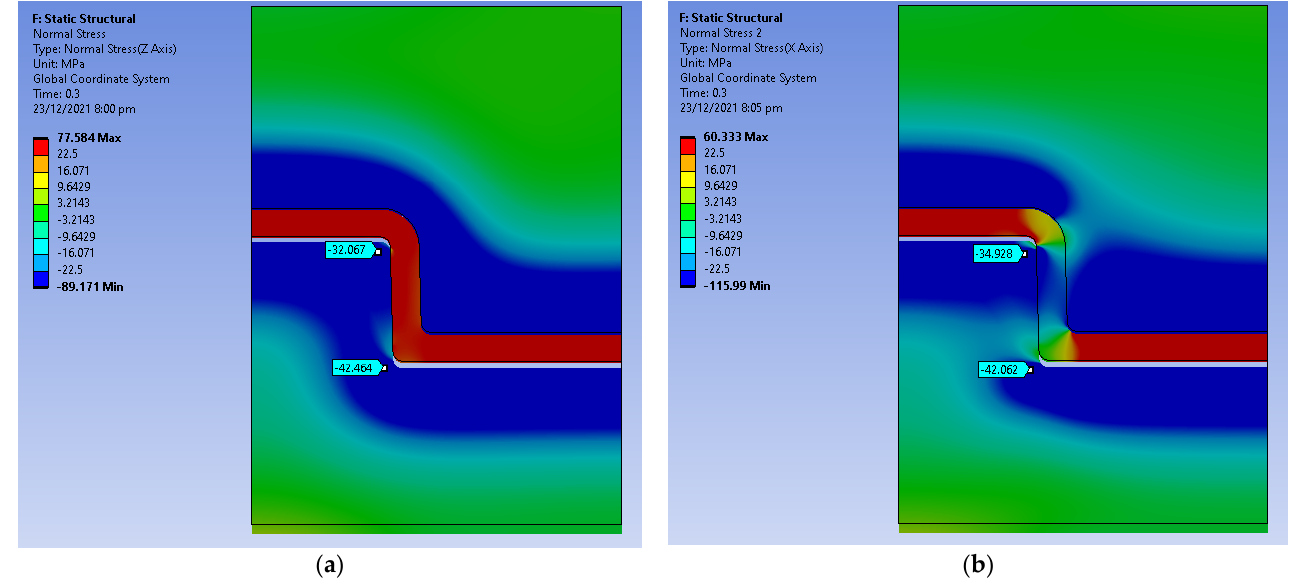
Figure 15. ( a ) Hoop Stress at 0.3 s (0.5 mm displacement); ( b ) Radial Stress at 0.3 s (0.5 mm displacement).